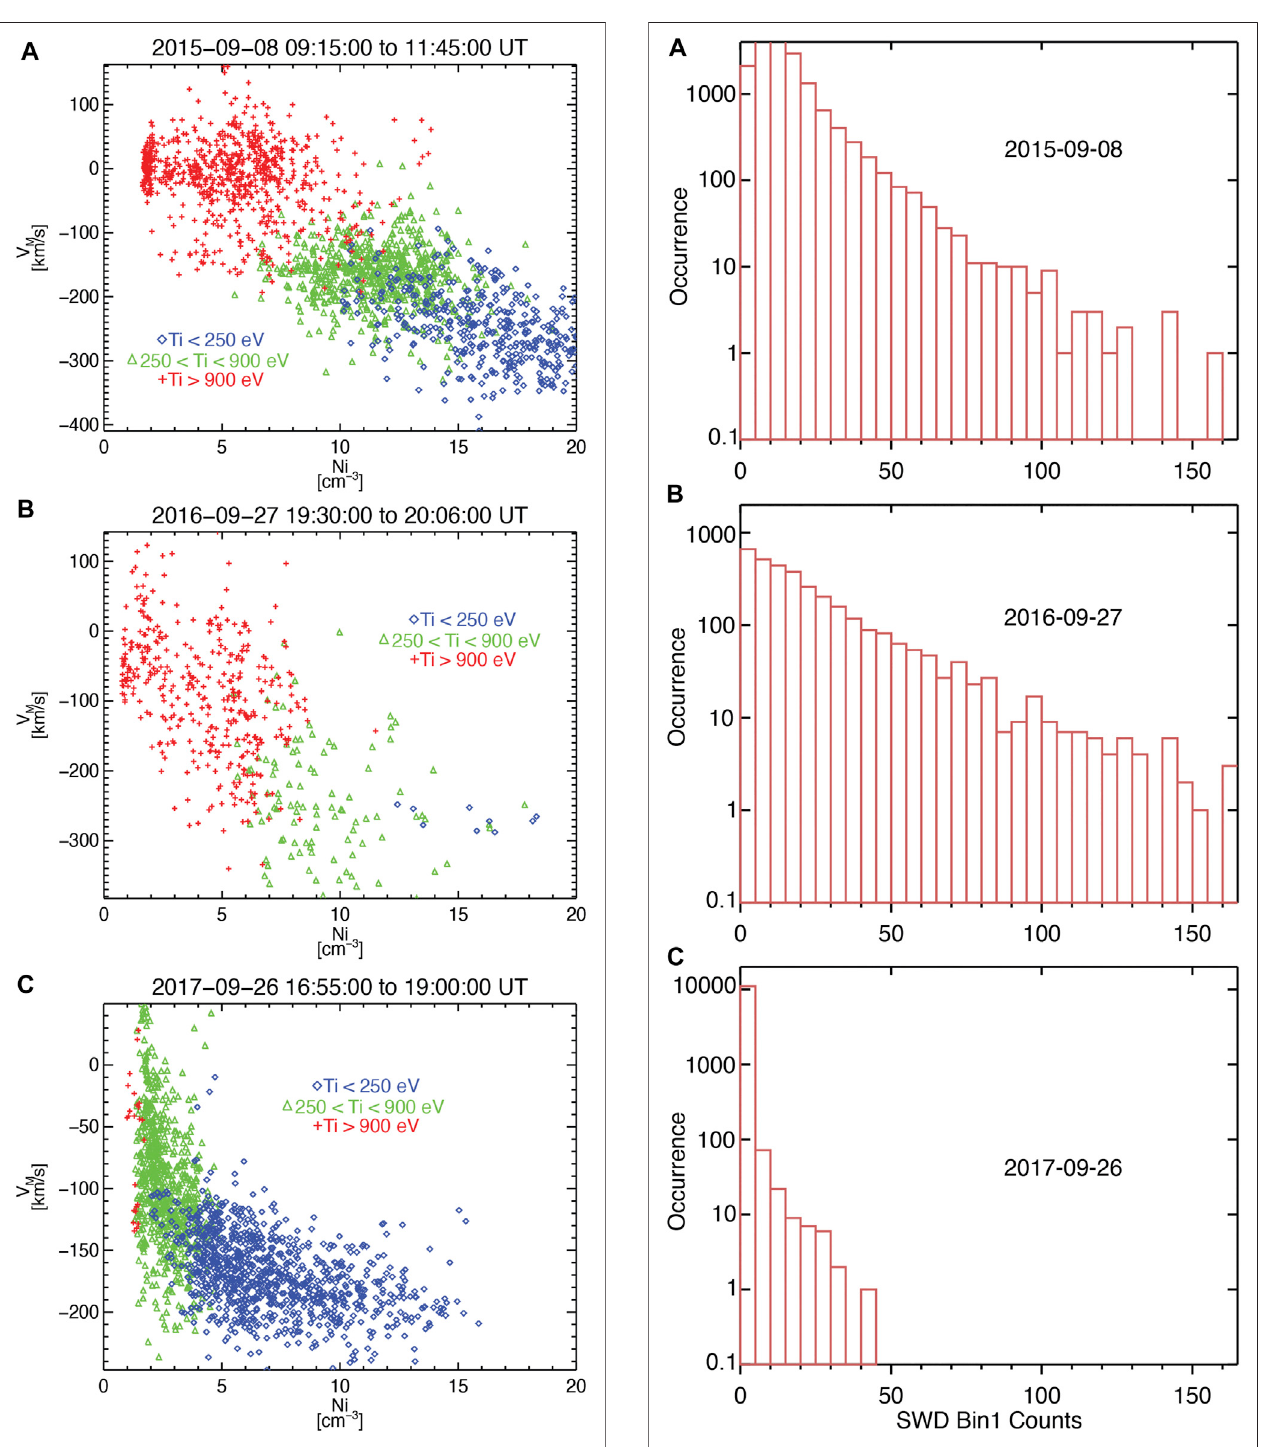
FIGURE 8 | V M vs. plasma number density color coded by ion temperature,forthreeK-Helmholtzintervalson (A) 2015-09-08, (B) 2016-09- 27, and (C) 2017-09-26.